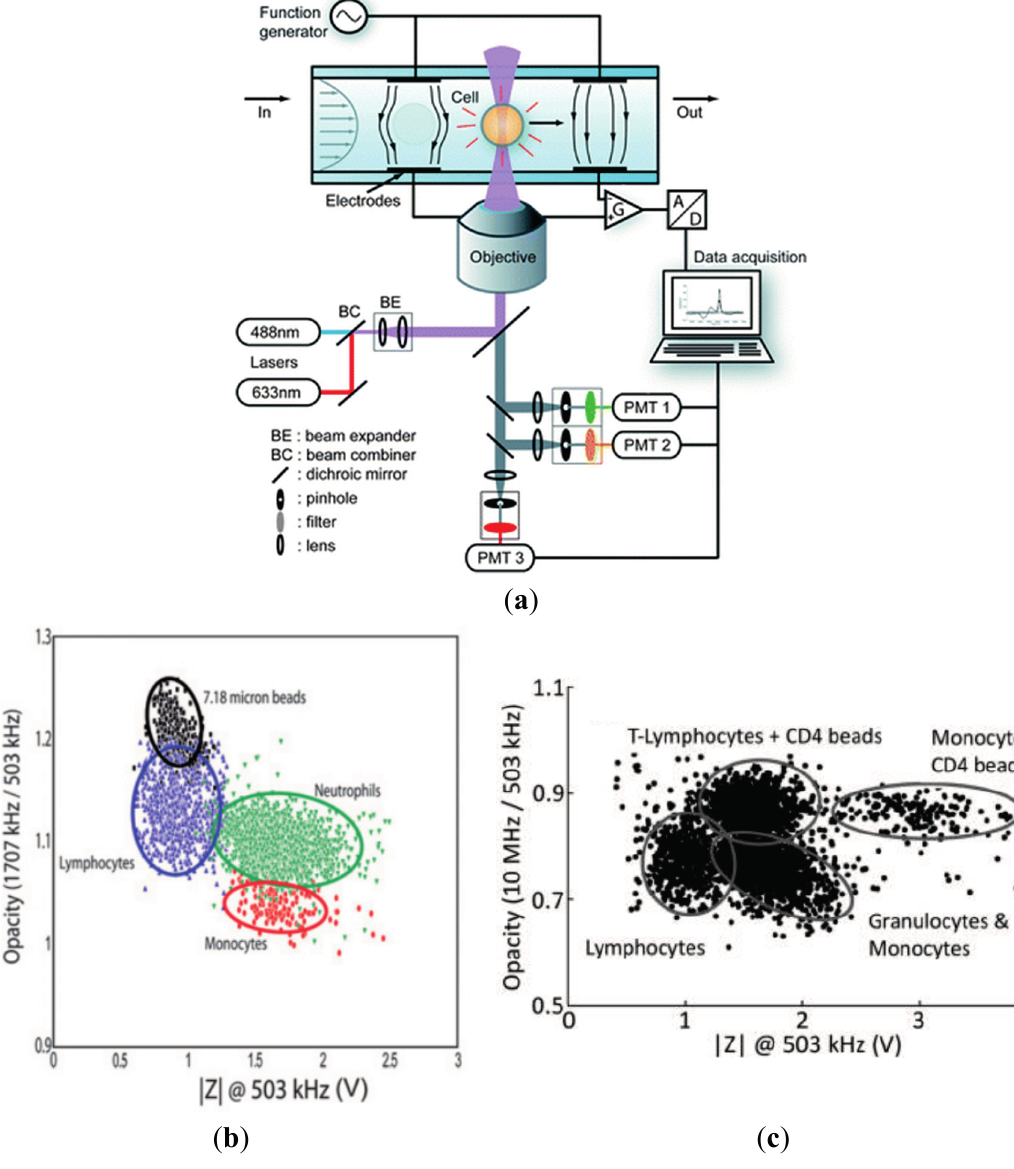
Figure 6. ( a ) The first-generation microfluidic impedance and fluorescent flow cytometry where a cell flows between two pairs of electrodes and the optical detection region composed of dual laser excitation, three color detection and dual frequency impedance measurement; ( b ) Impedance and fluorescent measurement results. Based on low frequency impedance amplitudes, lymphocytes can be differentiated from monocytes and neutrophils due to significantly smaller cell sizes. High frequency impedance amplitudes were used to differentiate neutrophils from monocytes due to significant differences in membrane capacitance. Note that these impedance based classification were validated by the simultaneous fluorescent detection by fluorescently labelling whole blood cells; ( c ) Whole blood cells mixing with CD4 antibody coated beads were characterized by the microfluidic impedance and fluorescent flow cytometry where lymphocytes, lymphocytes + CD4 beads, granulocytes & monocytes and monocytes + CD4 beads were successfully classified and confirmed by simultaneous fluorescent characterization